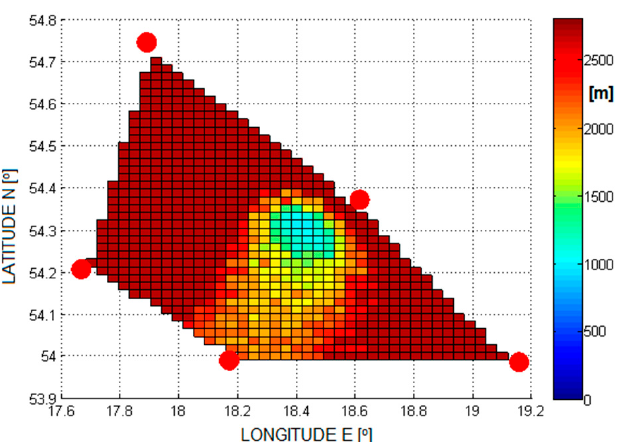
Figure 6. The RMSE of 2D position estimation in (m) for the Foy algorithm (TDoA error is ±2 μ s).